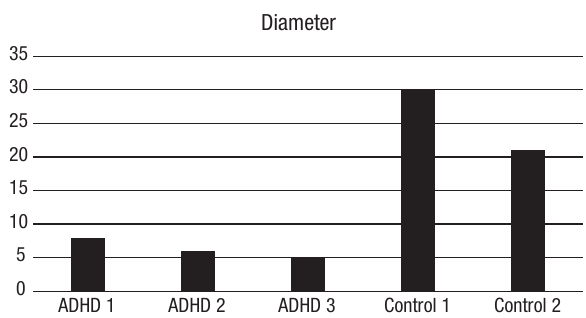
Figure 3. Diameter is the length among the longest of the shortest path between the node pairs of a network. Diameter indicates the linearity of the narrative.